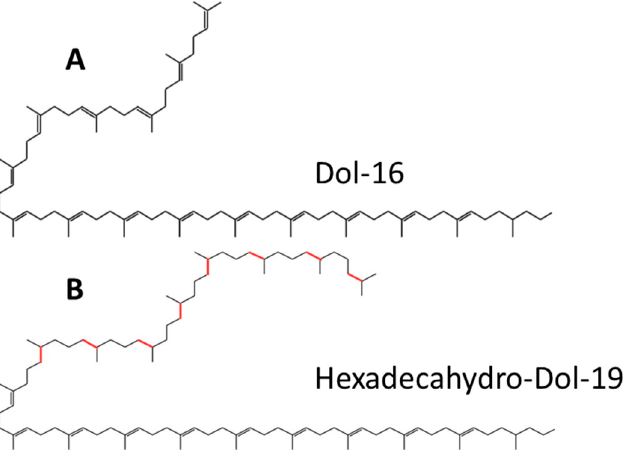
Figure 1. Dominant dolichols in S. cerevisiae ( A ) and in Trichoderma ( B ). Additional saturated bonds at the omega end in dolichol from Trichoderma in red.